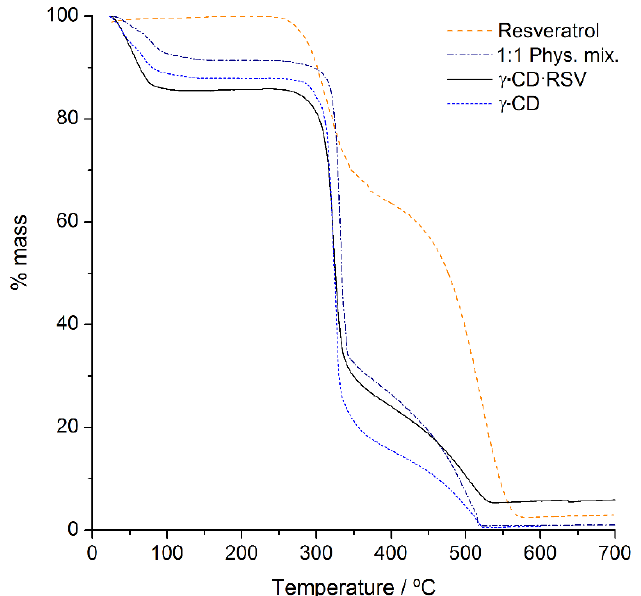
Figure 3. Thermogravimetric traces of RSV (dashed line), γ-CD·RSV (solid line), the 1:1 physical mixture of γ-CD with RSV (dash-dot line), and γ-CD (short-dash line).